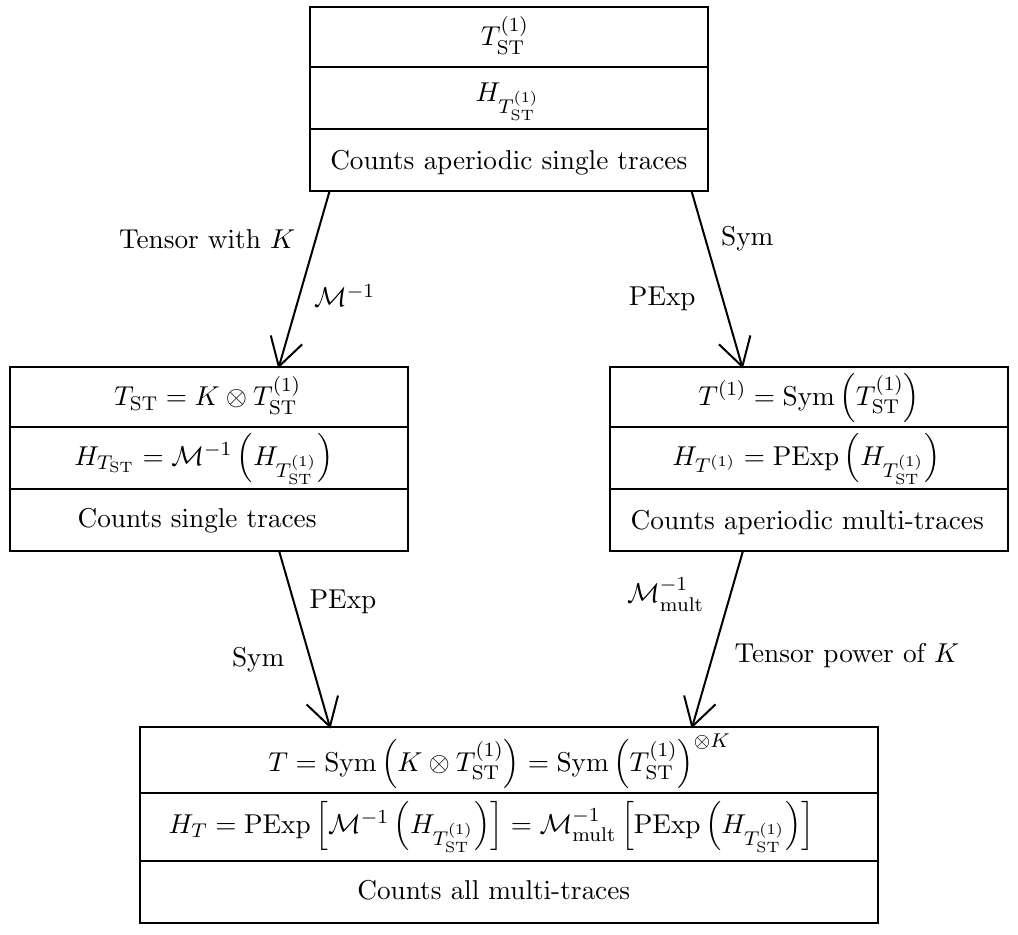
Figure 7 . Diagram summarising the structure of T , the space of U( N ) multi-traces, and its relation to T (1) , the space of U( N ) aperiodic single ST